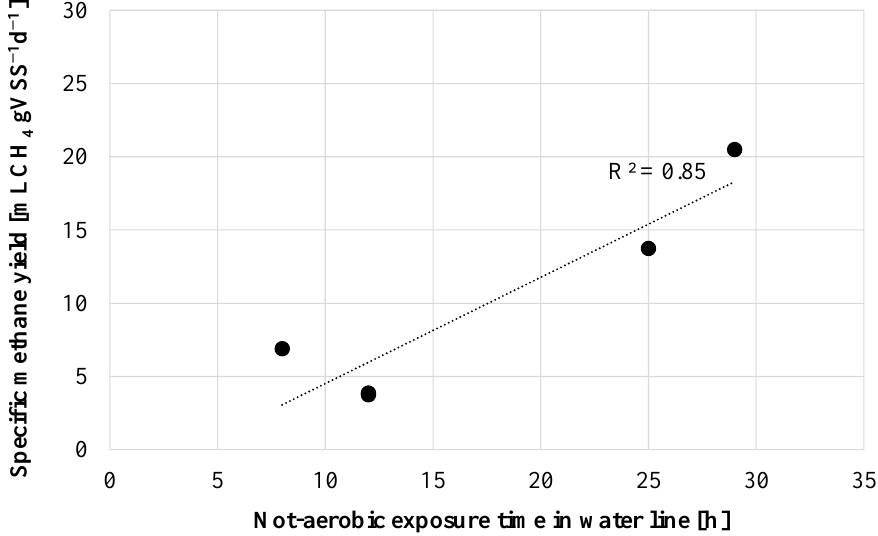
Figure 5. Correlation between the methane productivity and the exposure time to anaerobic